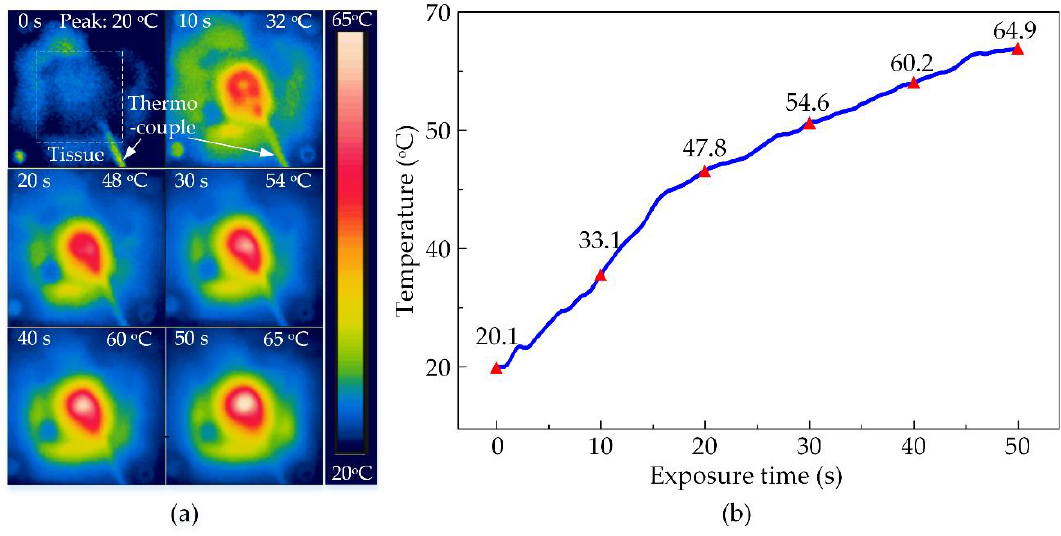
Figure 7. The observed temperature of chicken breast tissues during HIFU treatment at ± 21 V output voltage after 50 s ( a ) By thermal camera ( b ) By thermocouple.